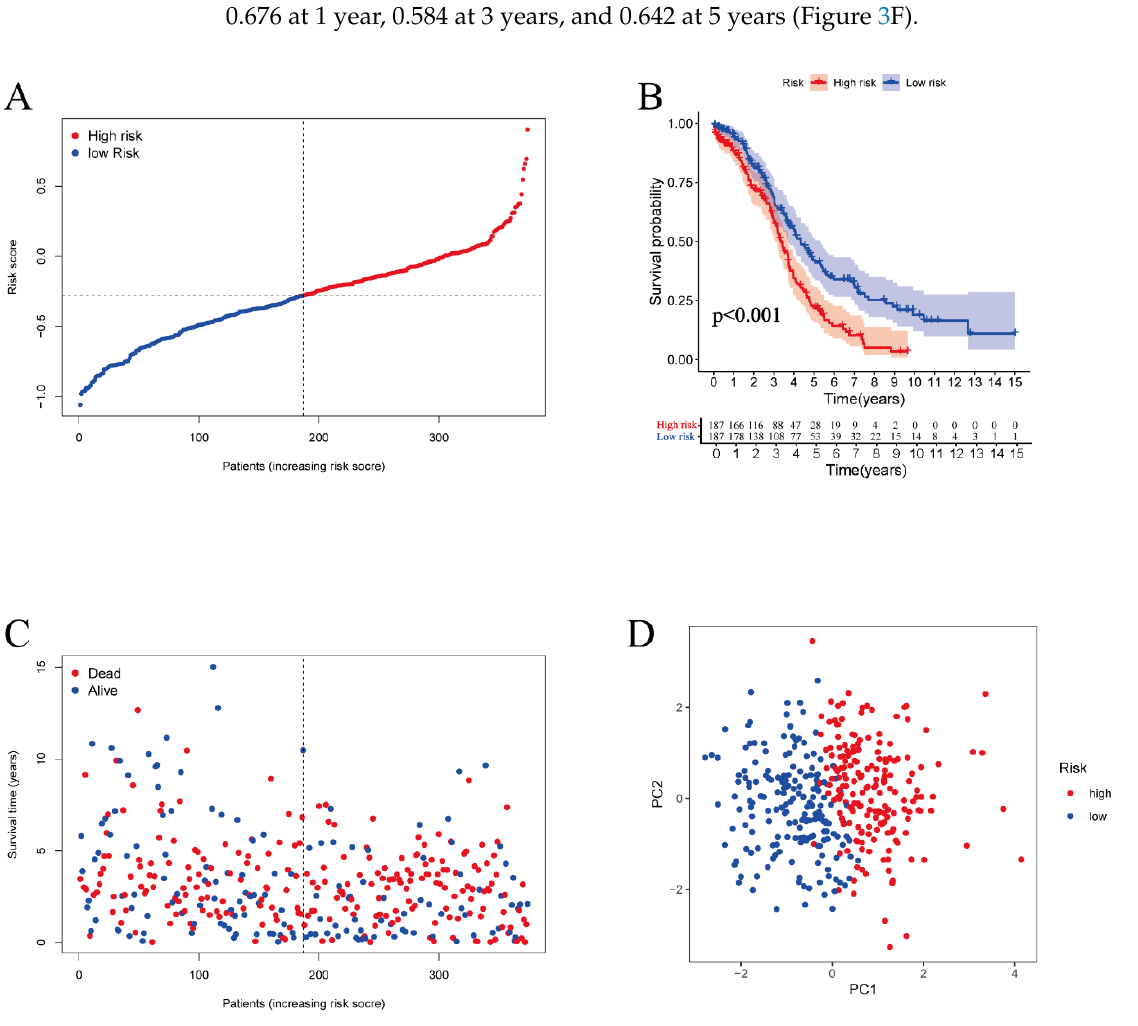
Figure 3. Construction of a prognostic signature in the TCGA cohort. (A ) Distribution of the risk score in the TCGA cohort. ( B ) Kaplan – Meier survival curve for OS of ovarian cancer in the TCGA cohort. ( C ) Distribution of survival status and risk score of each patient. ( D ) PCA plot of the TCGA cohort by 5 genes. ( E ) t-SNE analysis in the TCGA cohort by 5 genes. ( F ) ROC curve demonstrating the predictive efficiency of the 5-gene prognostic signature in the TCGA cohort.